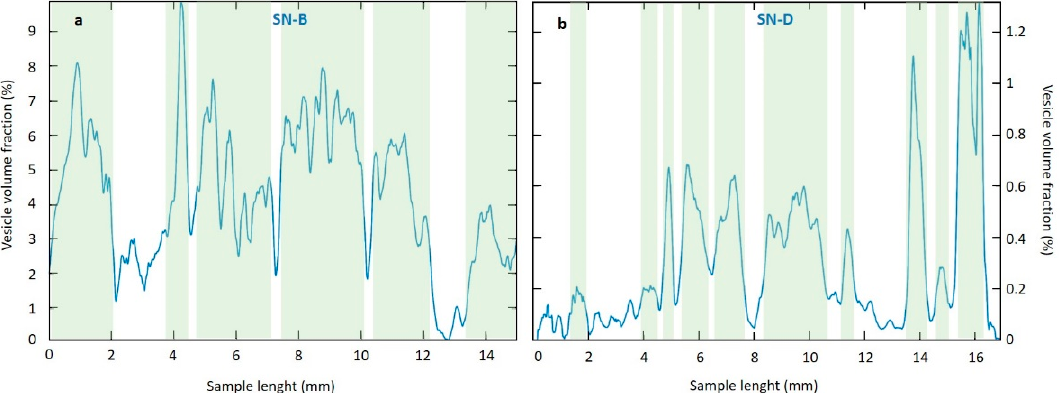
Figure 6. Variation of total vesicularity, expressed as vesicles volume fraction, in a direction orthogonal to the bands (z axes in Figure 5). A moving average was used to slightly smooth the plot. ( a ) Sample SN-B; ( b ) sample SN-D. The green shaded areas in each plot indicate the corresponding light green color regions in the macroscopic sample.